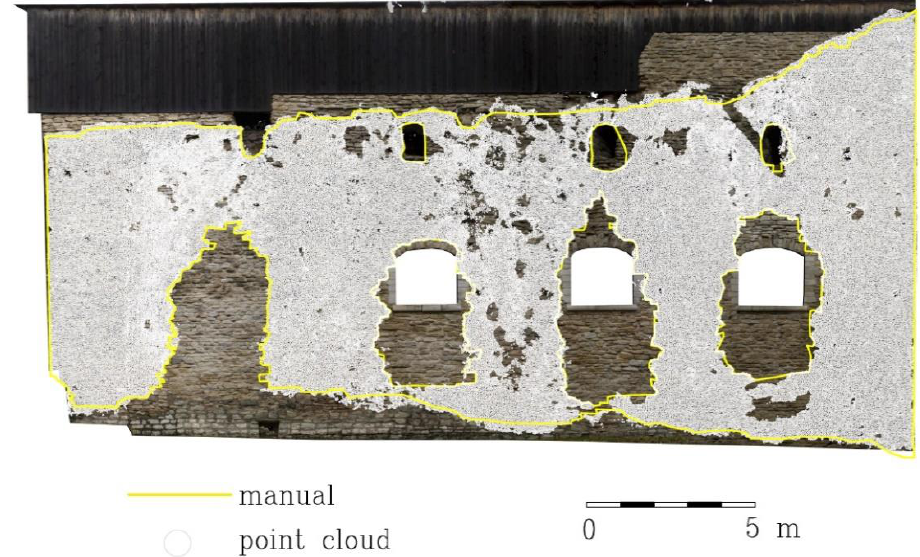
Figure 10. Overlay of the point cloud where differences of Cloud/Cloud comparison were under chosen threshold of 0.05 m and of the orthophoto with the manually created boundary of preserved stones.